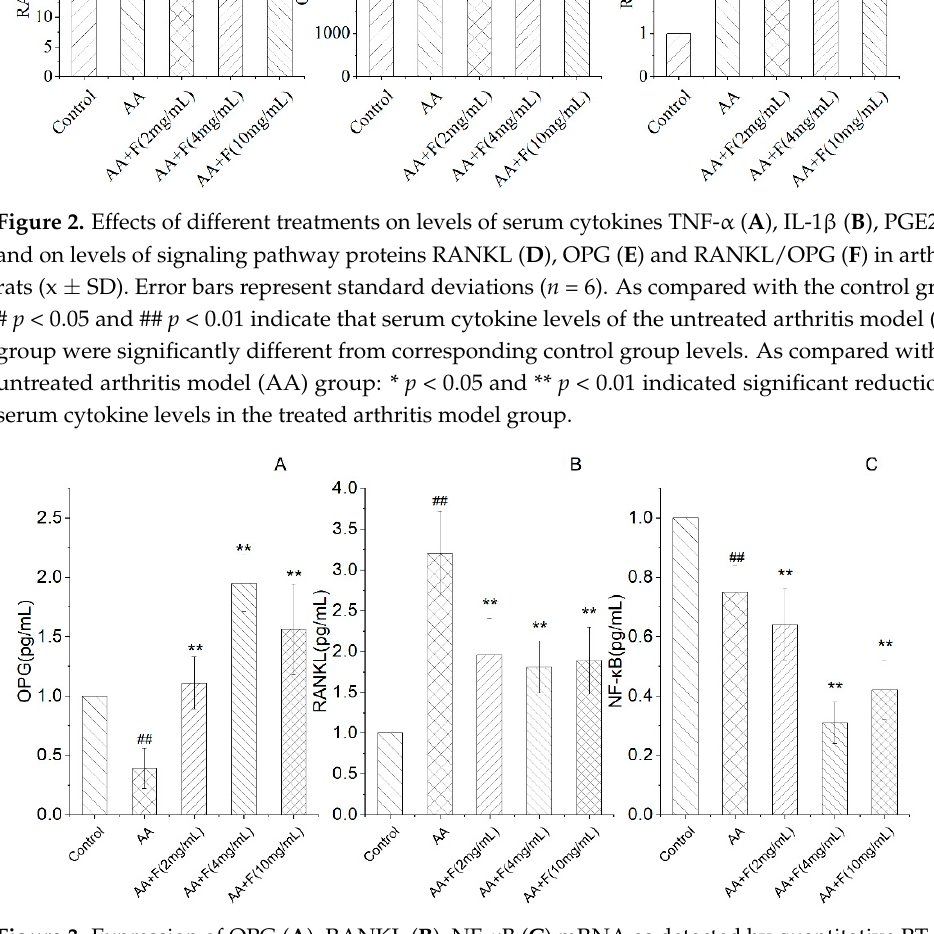
Figure 3. Expression of OPG ( A ), RANKL ( B ), NF ‐κ B ( C ) mRNA as detected by quantitative RT ‐ PCR (x ± SD). Error bars represent standard deviations ( n = 3). As compared with the control group, ## p < 0.05 indicates that mRNA expression levels of OPG and NF ‐κ B decreased and the mRNA expression level of RANKL increased in the arthritis model (AA) group. As compared with the AA group, ** p < 0.01 indicates that groups of treated arthritic rats exhibited increased expression of OPG mRNA, decreased expression of RANKL mRNA, and significant inhibition of NF ‐κ B signaling pathway activity.